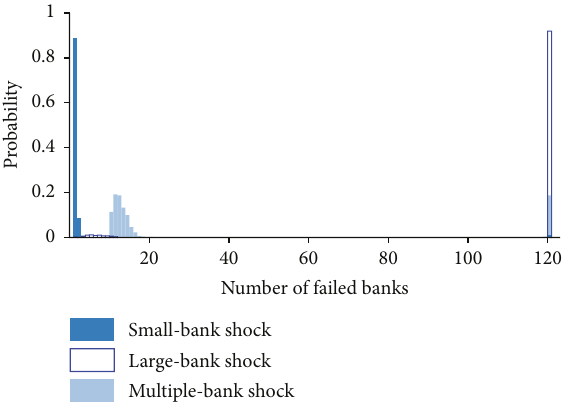
Figure 7: Probability of whole-system breakdown in complete information (CI) and local information (LI) scenarios. The LI1 scenario obtains the highest probability of systemic breakdown in both single-bank shock treatments. LI1 and LI2 =scenarios in which banks have access only to information from banks up to distance 1 and 2, respectively (Figure 15 in Appendix A displays all